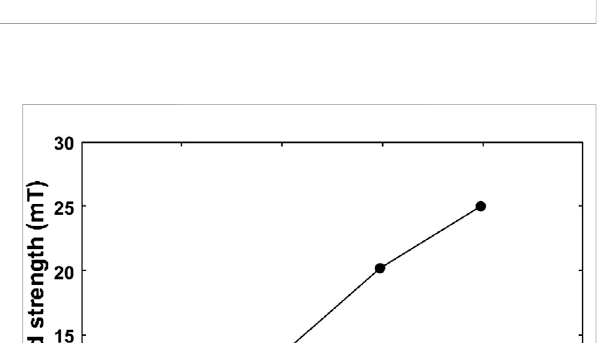
FIGURE 5 Composition of data acquisition.